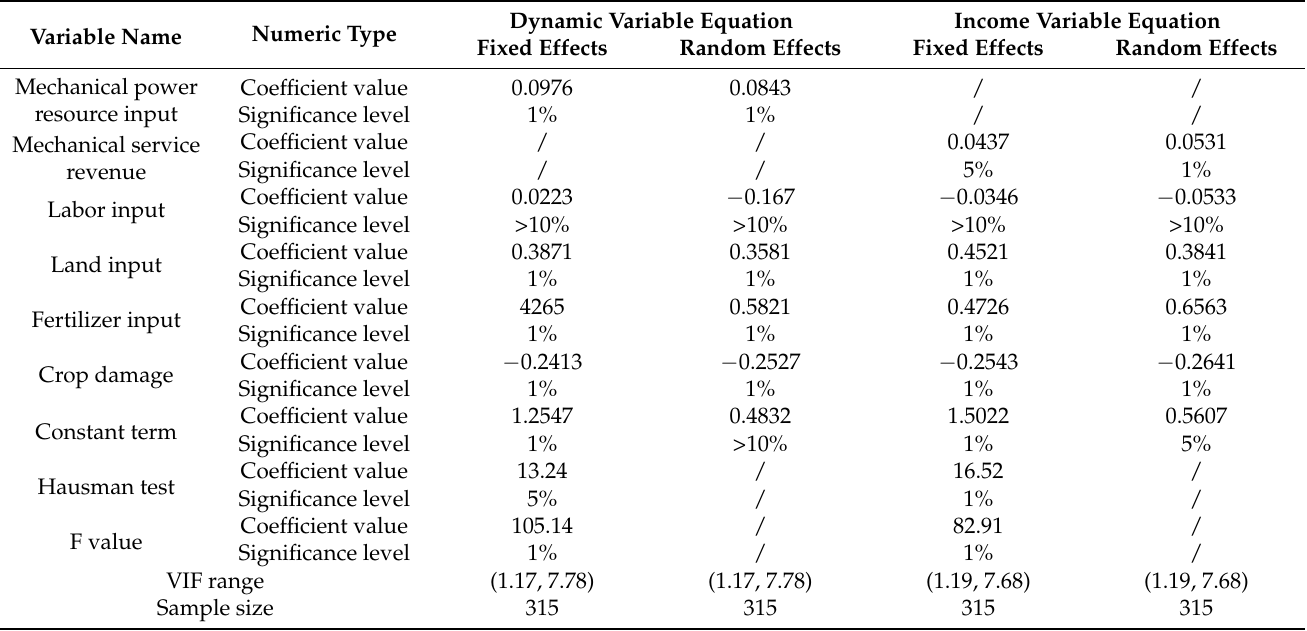
Table 4. Analysis of provincial panel data.